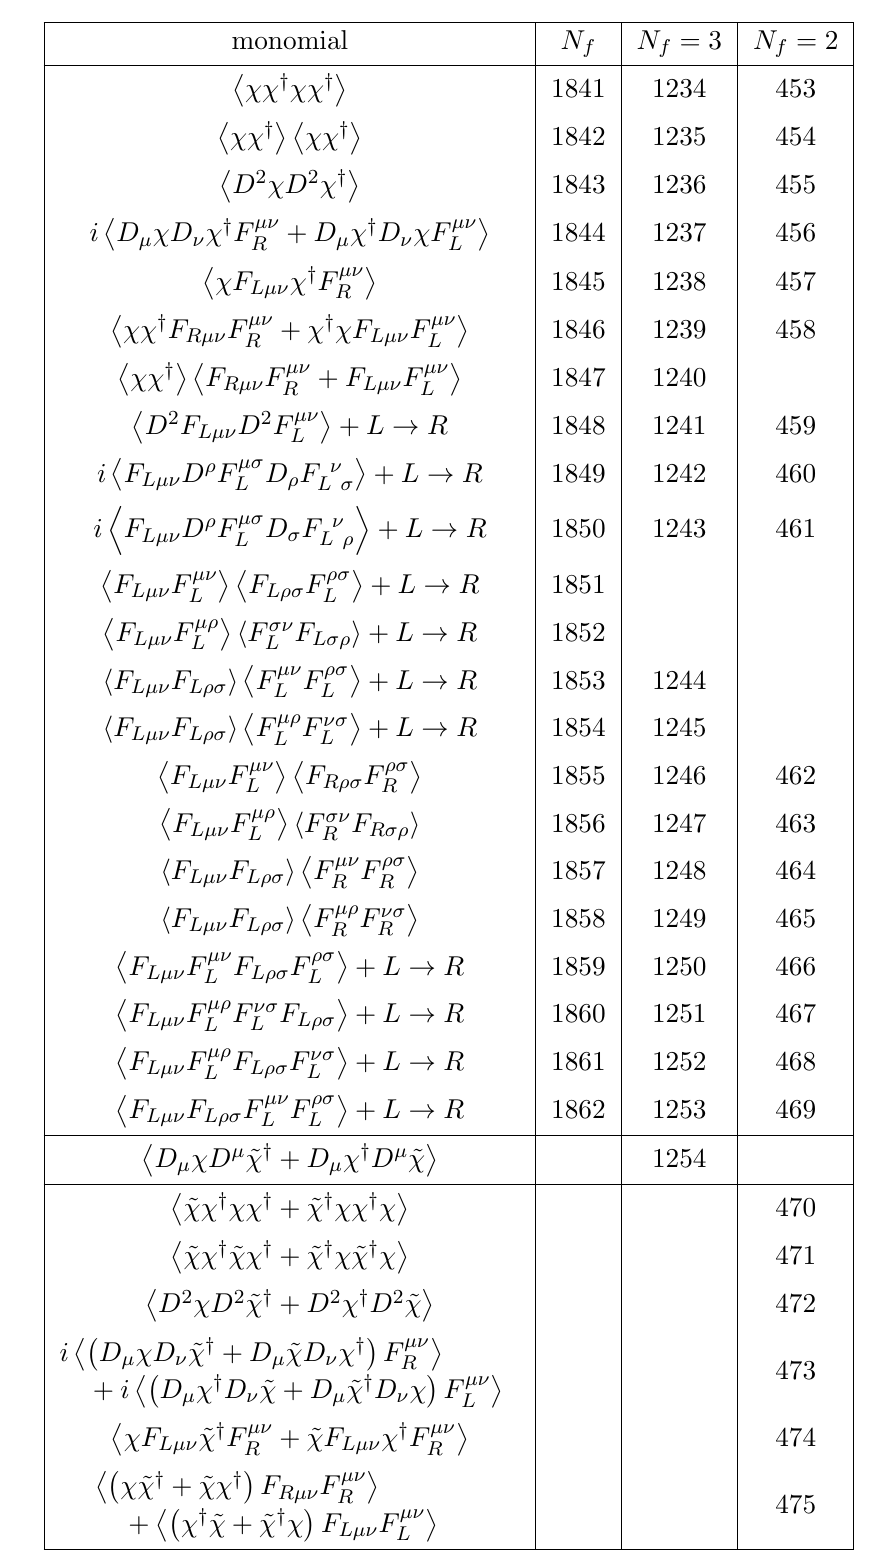
Table 8 . The list of contact terms and the number in the minimal basis for a general number of (cid:13)avours N f and for N f = 2 ;